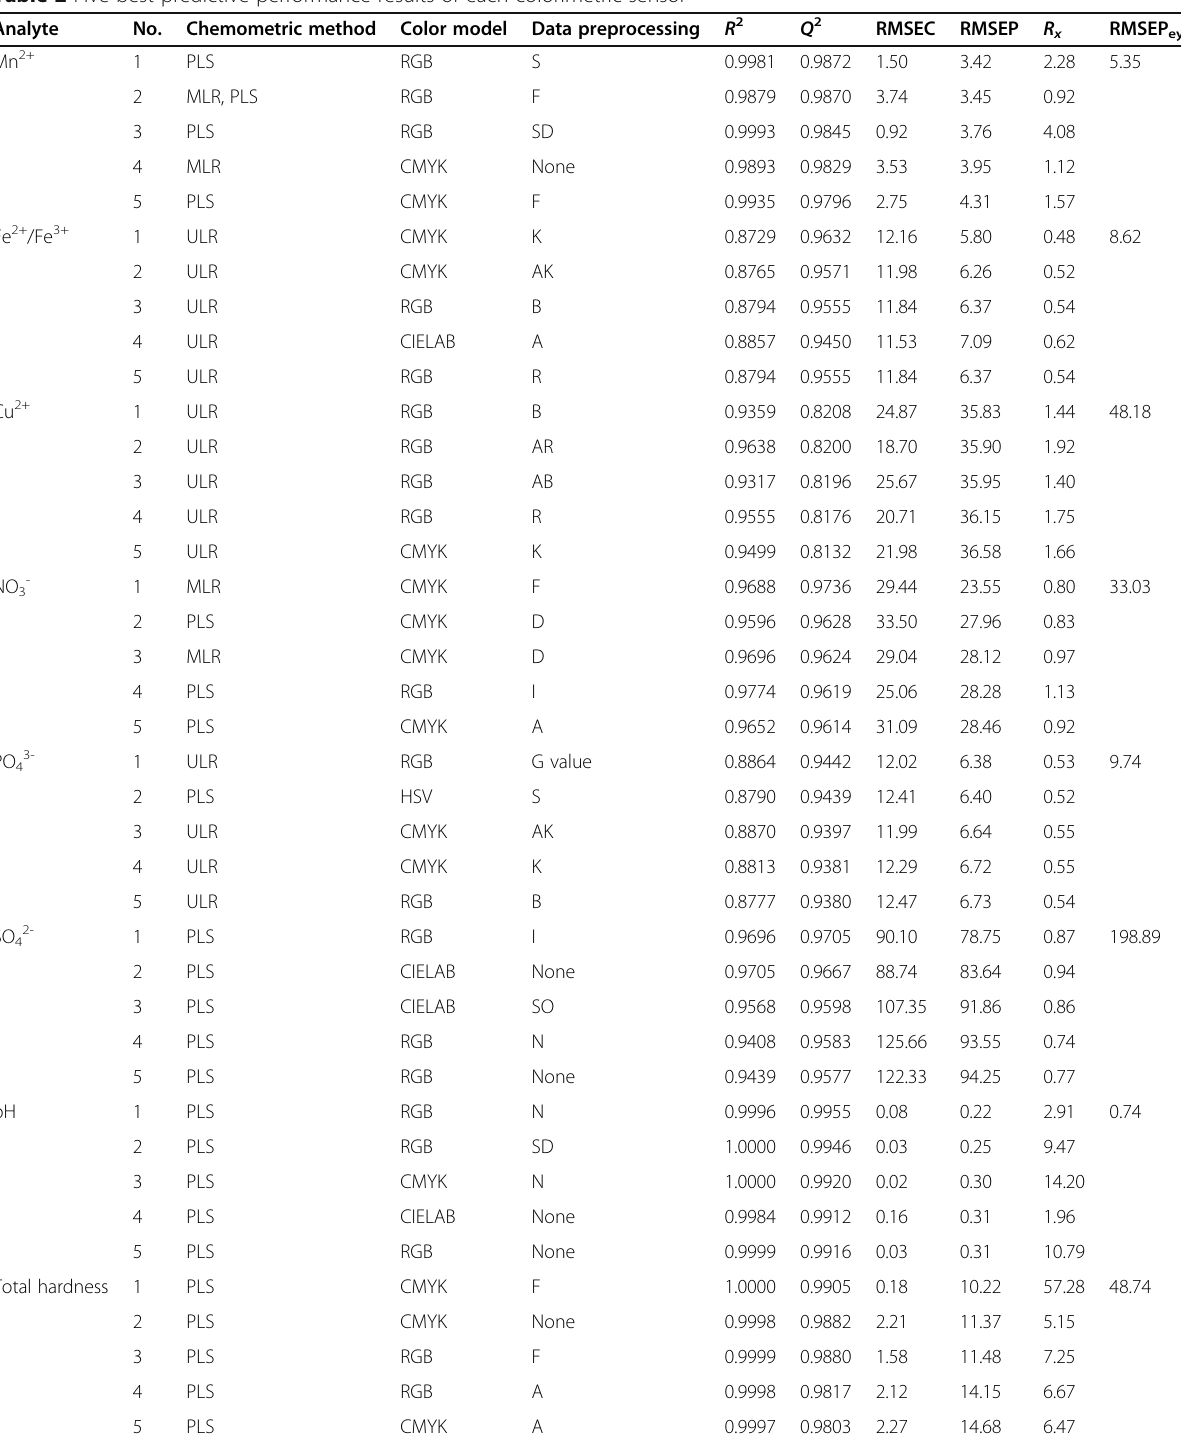
A = Color change (different intensities before and after the chemical exposure), AR = Change of red parameter, B = Intensity of blue parameter, F = Color intensities were subtracted by background, I = Logarithm, N = Normalization, S = Standardization, SO = Standardization of a* and b* parameters, AB = Change of blue parameter, AK = Change of black parameter, D = Absolute value of color change, G = Intensity of green parameter, K = Intensity of black parameter, R = Intensity of red parameter, SD = Standardizatjon of color change, RMSEP eyes = Predictive errors using naked